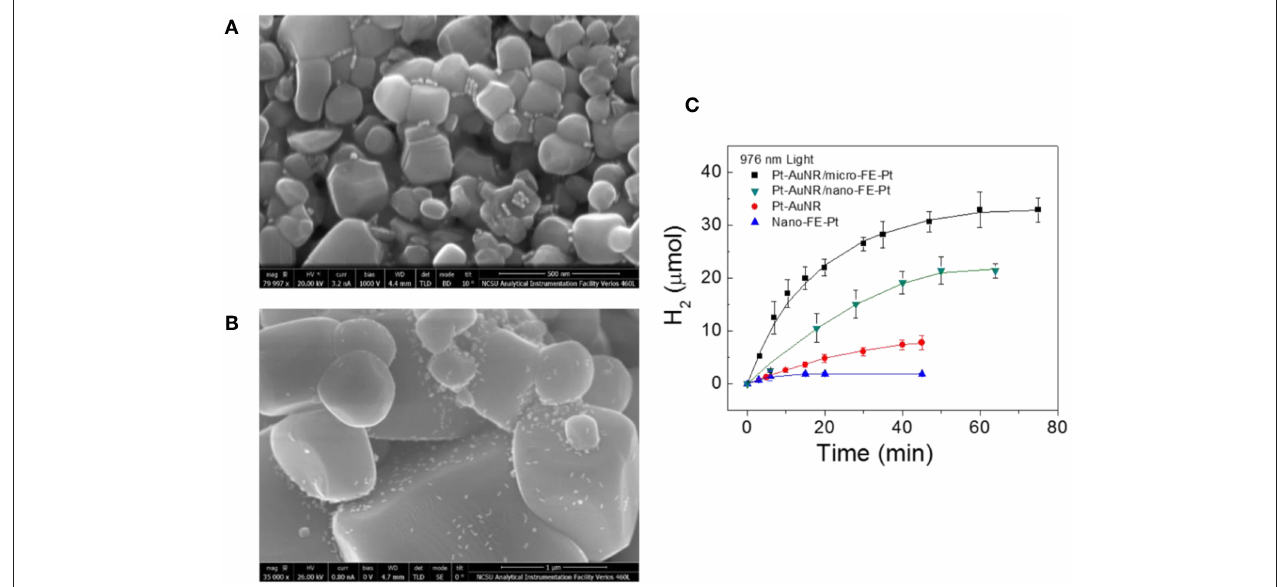
FIGURE 11 | SEM images of ferroelectric PT particles impregnated with Pt-end-capped AuNRs, for the (A) nano-PT particles with dimensions of ∼ 125nm and for the (B) micro-PT particles with dimensions of ∼ 1 µ m. The AuNRs appear as white dots, with scale bars of 500nm. (C) Hydrogen production vs. time for